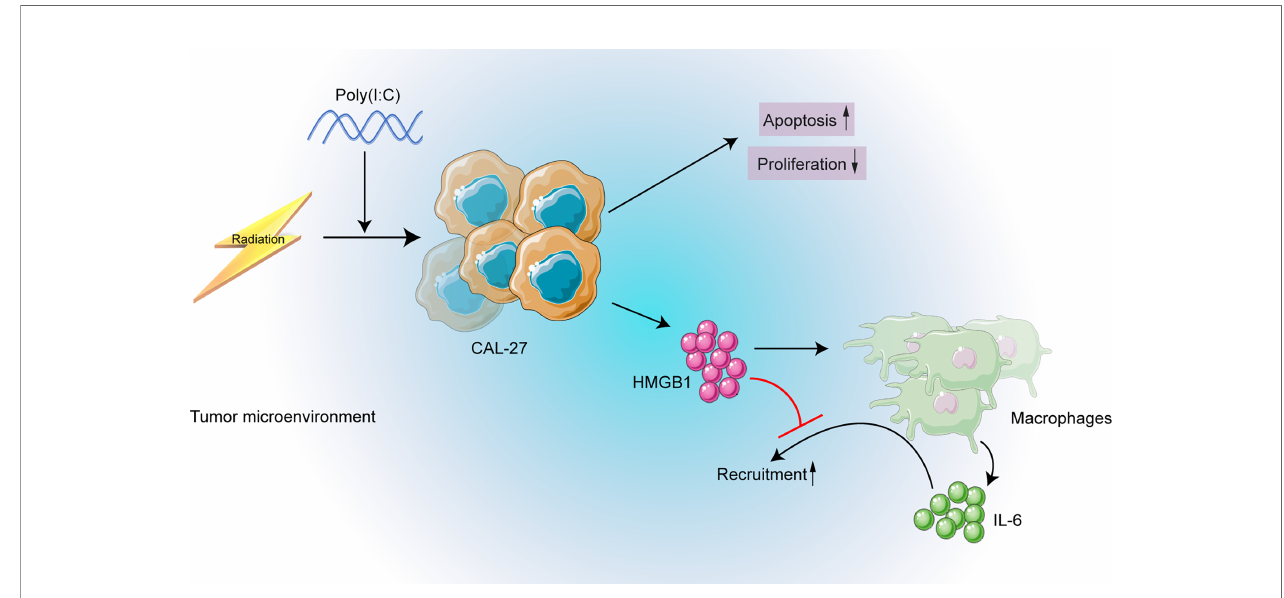
FIGURE 8 | The schematic diagram depicting the strategy of targeting HMGB1 may enhance radiosensitivity of CAL-27 cells by inhibiting macrophage recruitment induced by